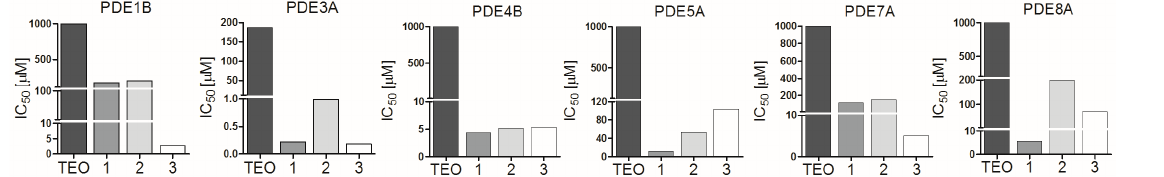
Figure 2. Graphical representation of IC 50 values ( μ M) of 1 , 2 , 3 , and TEO against selected PDEs. The IC 50 values for PDE1B, 3A, 4B, 5A, 7A, and 8A were published in [23,25], except PDE8A IC 50 for TEO, which was determined in this study and was over 1000 μ M.